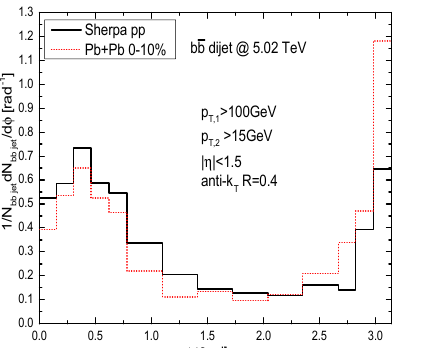
Figure 12. Azimuthal angle distributions of b ¯ b dijets in p + p and Pb + Pb collisions at the LHC with minimum cut of b jet momentum p T = 15